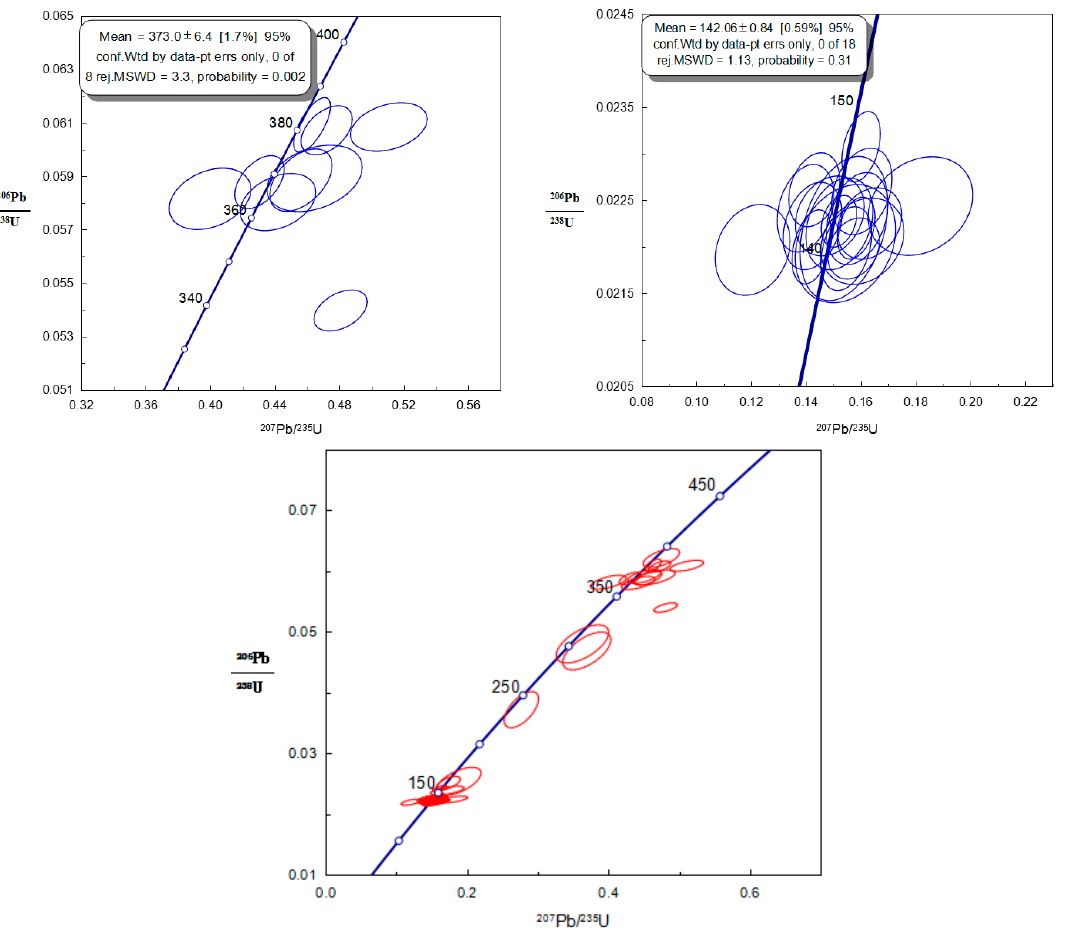
Figure 7. Concordant age diagram and weighted mean age of LA ‐ ICP ‐ MS zircon 207 Pb/ 235 U ‐ 206 Pb/ 238 U of porphyritic granite from Dongping deposit (D35 sample).